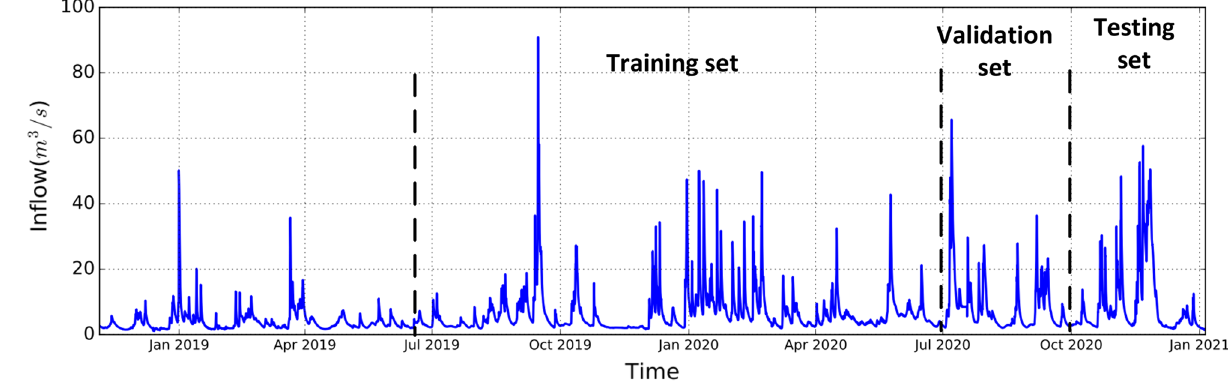
Figure 5. Hourly inflow time-series at Location 8: one year of data is used for training and 6 months of data is used for validation and